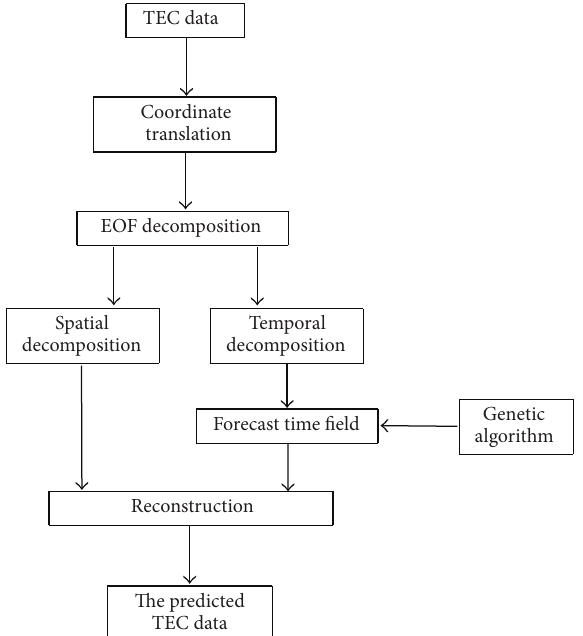
Figure 1: General graphical procedures of forecasting